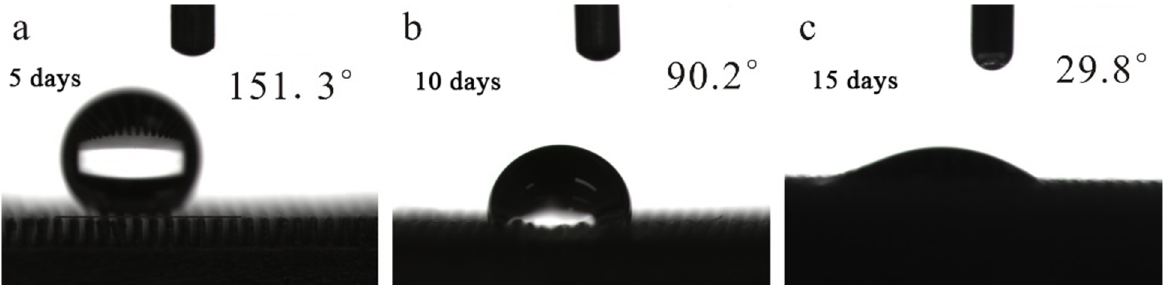
Figure 5. Contact angle of 3D-printed + modified samples placed outdoors for different time.